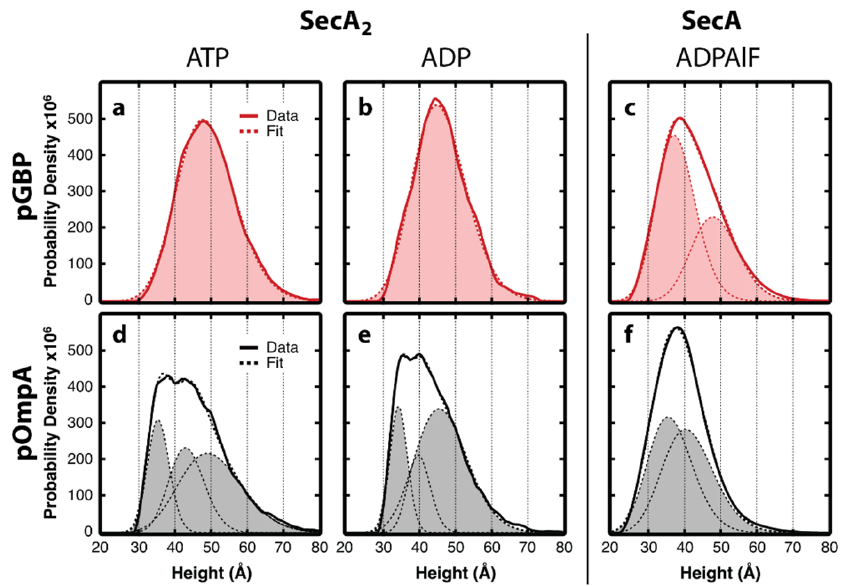
Figure 10. Translocase conformational changes with nucleotide. Height distributions for translocases engaging pGBP when exposed to ( a ) ATP (n = 3431), ( b ) ADP (n = 1128), or ( c ) ADPAlF (n = 1860), as well as translocases engaging pOmpA when exposed to ( d ) ATP (n = 1047), ( e ) ADP (n = 661), or ( f ) ADPAlF (n = 2112). Only translocases exhibiting volumes in the range corresponding to SecA 2 or SecA monomer were included, as indicated. Bayesian information criterion was used to determine the optimal number of gamma distributions for each fit. The analysis prescribed one gamma distribution for ( a , b ), two for ( c , f ), and three for ( d , e ). Data are adapted from Ref. [15]. For both precursors, a primary difference between ATP and ADP appeared in an overall ~3-Å shift to higher heights in the presence of ATP, accompanied by an approxi- mately 20% enhancement in the full width at half maximum of the height peaks. These changes are likely attributable to conformational dynamics associated with ATP